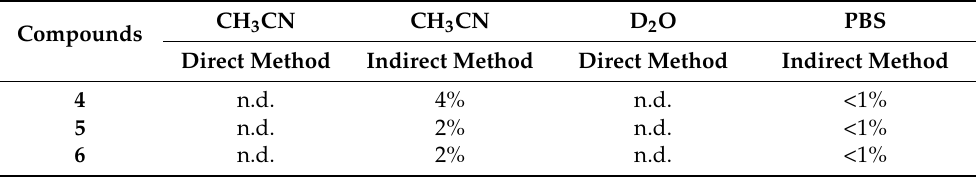
Table 1. Singlet oxygen quantum yields ( Φ ( 1 O 2 )) in CH 3 CN and aqueous solution determined by a direct and an indirect method upon excitation at 450 nm. Average of three independent measurements ( ± 10%). CH 3 CN CH 3 CN D 2 O PBS Compounds Direct Method Indirect Method Direct Method Indirect Method 4 n.d. 4% n.d. <1% 5 n.d. 2% n.d. <1% n.d. 2% n.d. <1% n.d. = not